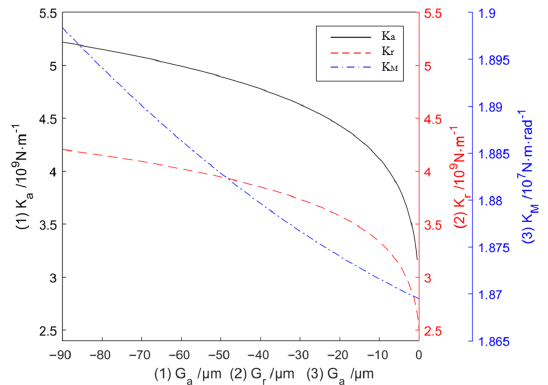
Figure 6. Variation of stiffness